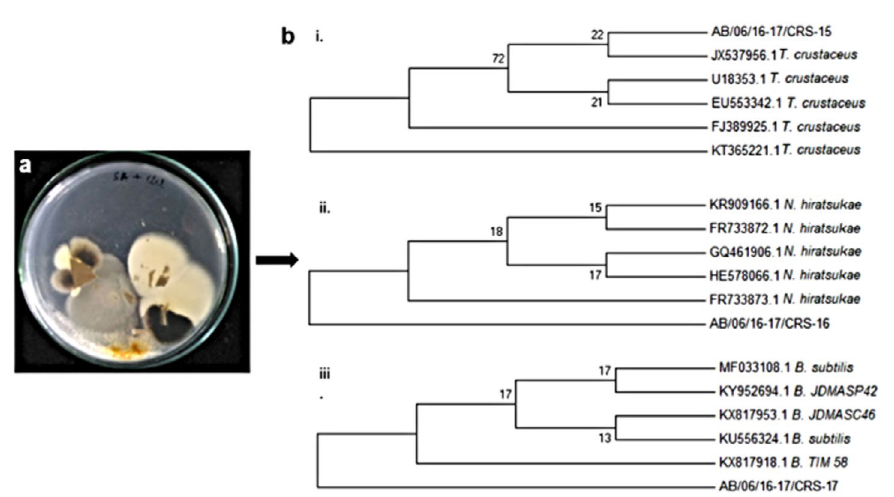
Fig. 1. Isolation of spoilage microorganism from cardboard using agar flooding method b. Phylogenetic tree of 16S rDNA gene sequences of i. T. crustaceus CRS-15 ii. N.hiratsukae CRS-16 iii. B. subtilis